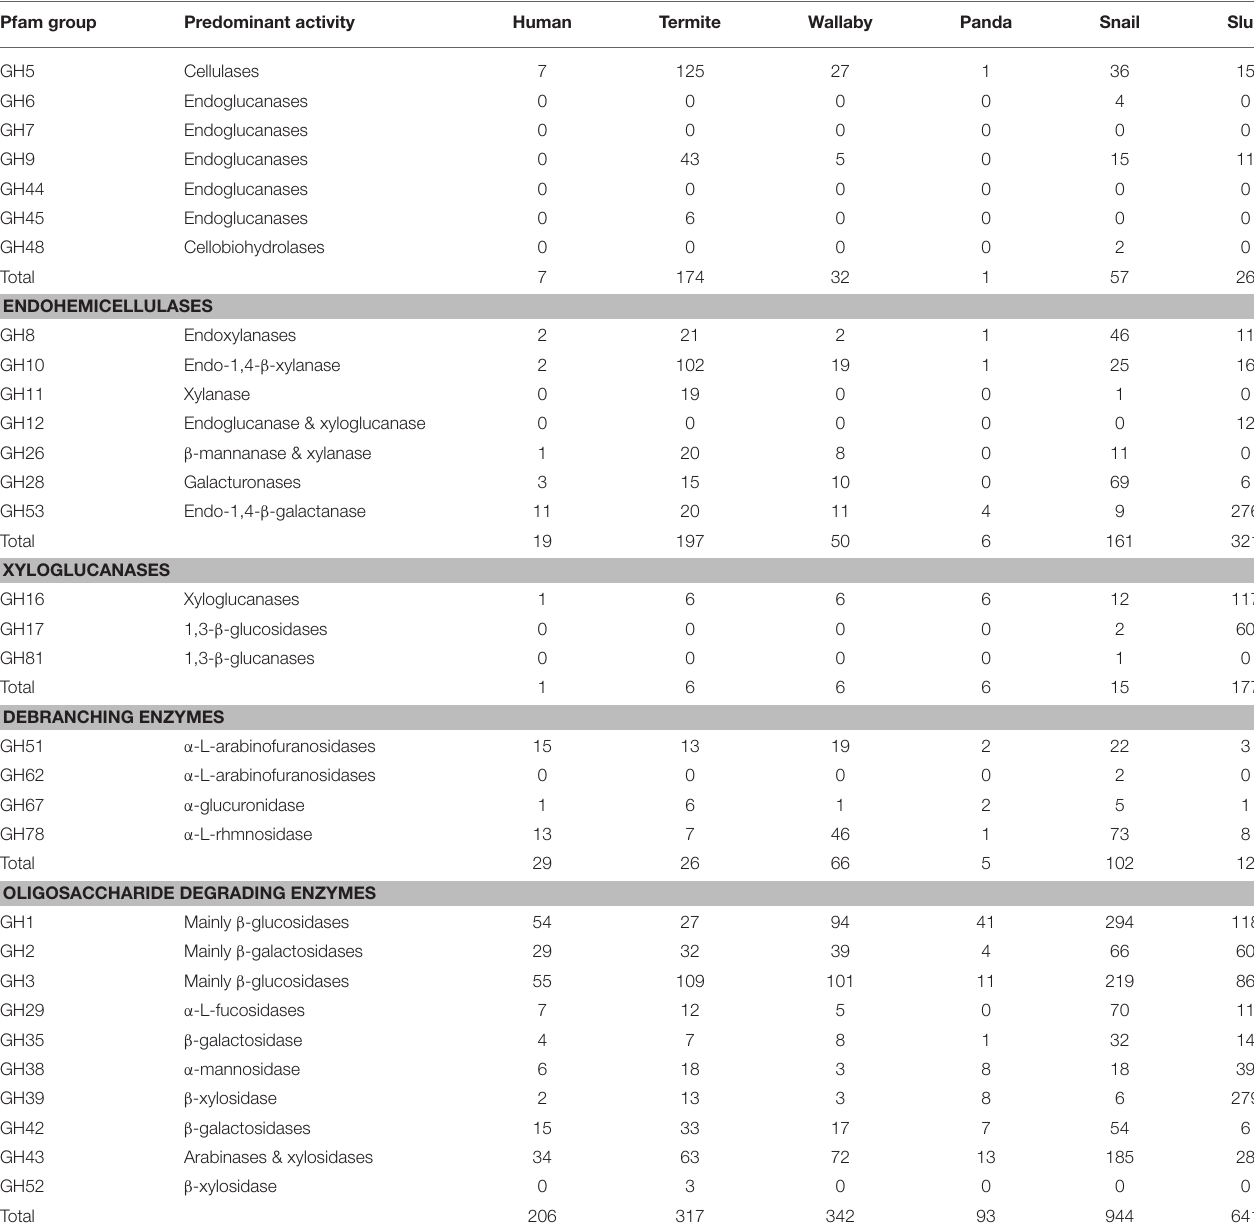
TABLE 4 | Comparison of the glycoside hydrolase (GH) profiles of human, termite, wallaby, giant panda, snail, and slug gut metagenomes as classified by Cardoso et al. (2012a) and Allgaier et al. (2010), showing GH groups that are involved in the breakdown/modification of plant cell wall polysaccharides. Pfam group Predominant